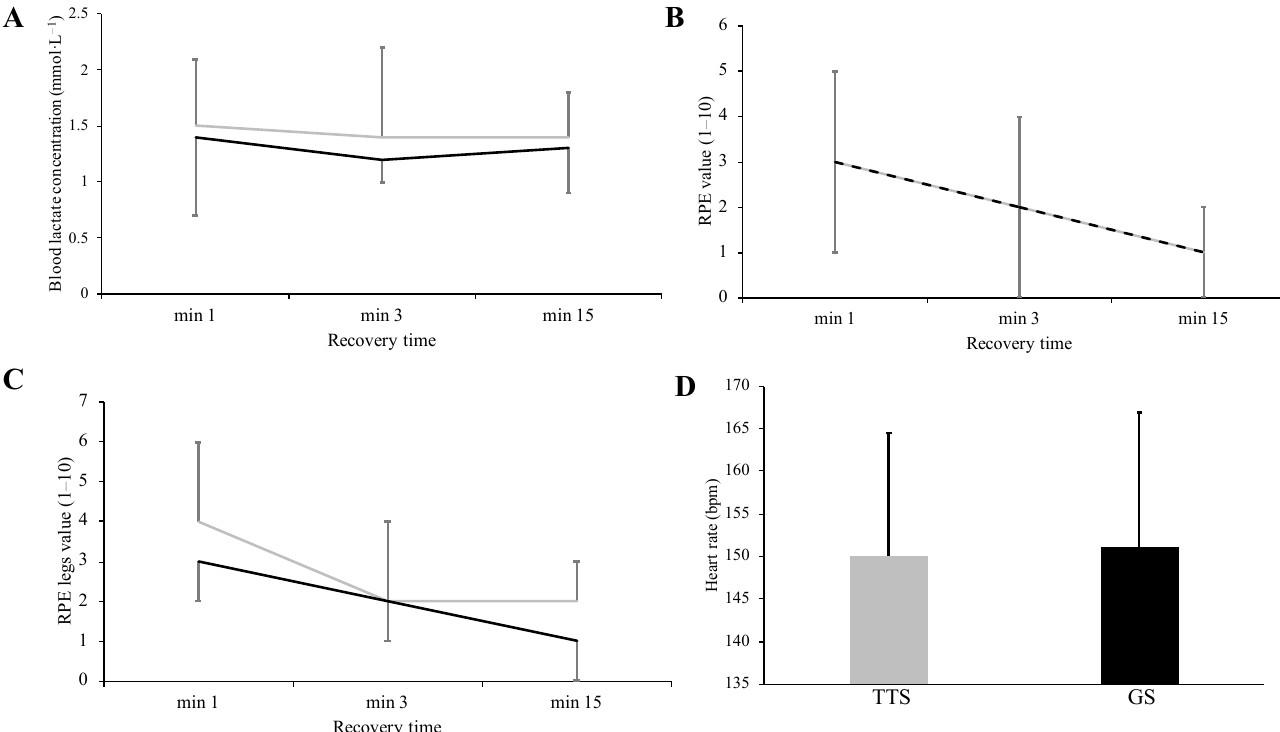
Figure 4. Blood lactate ( A ), whole-body rate of perceived exertion (RPE; B ), and legs-only RPE ( C ) during the recovery period after running in the traditional training shoe (TTS, gray solid line) or grounding shoe (GS, black solid line). Heart rate during the running economy trial in both TTS and GS trials ( D ). Dashed lines represent overlapping mean values between shoes.